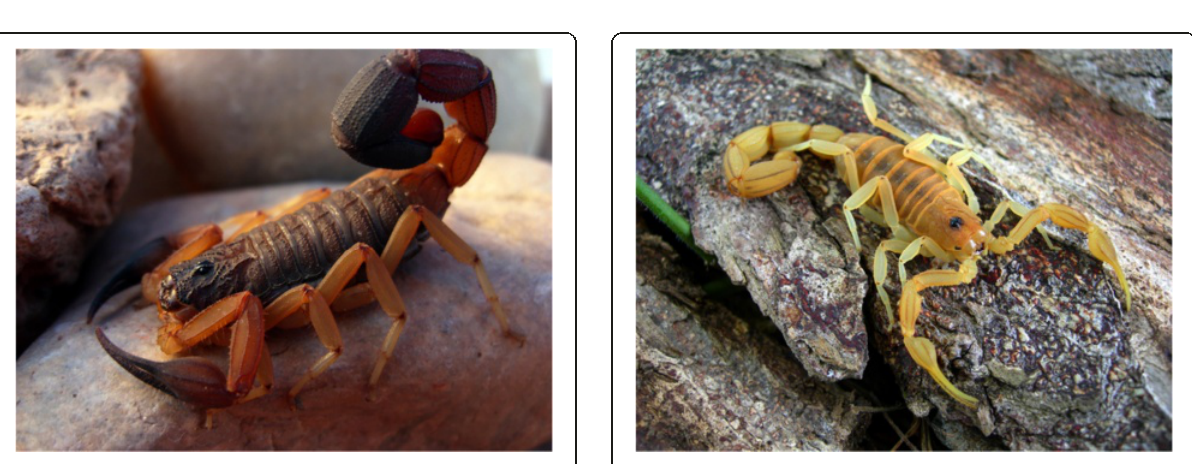
Fig. 17 Rhopalurus agamemnon (C. L. Koch, 1839); female from Brazil (copyright by Tiago Porto, reproduced with permission)